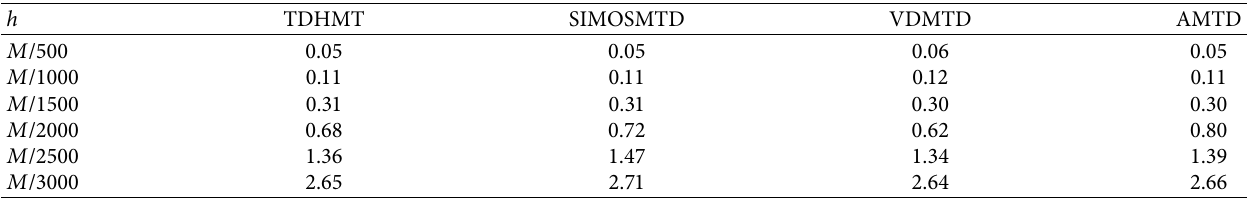
Table 14: Comparison of the CPU time of TDHMT with the CPU time of other existing methods, namely, SIMOSMTD, VDMTD, and AMTD for Example